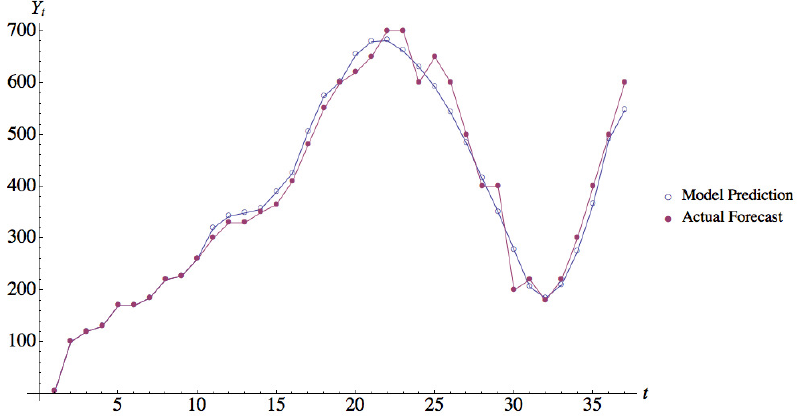
Figure 3. Data fit for Participant 14 in Session 1. Note that the first 10 periods were used for priming, hence are not included in the data fit.